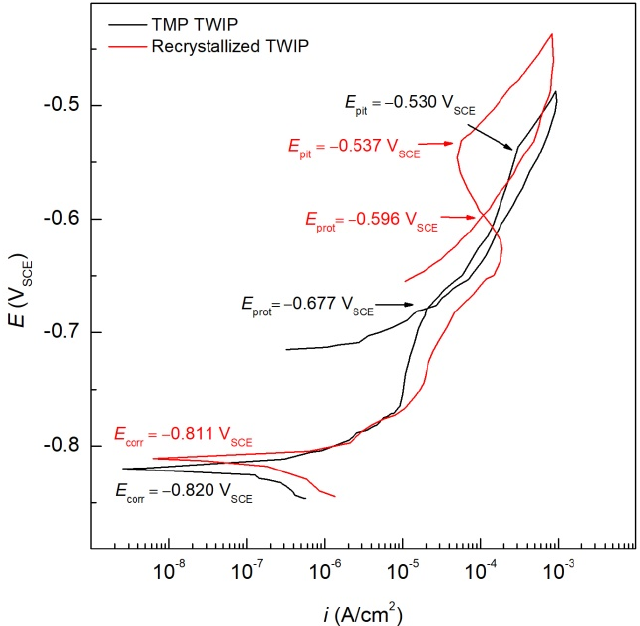
Figure 4. Cyclic potentiodynamic polarization CPP of TMP and recrystallized TWIP steels in deaerated 1.0 wt.% NaCl solution.